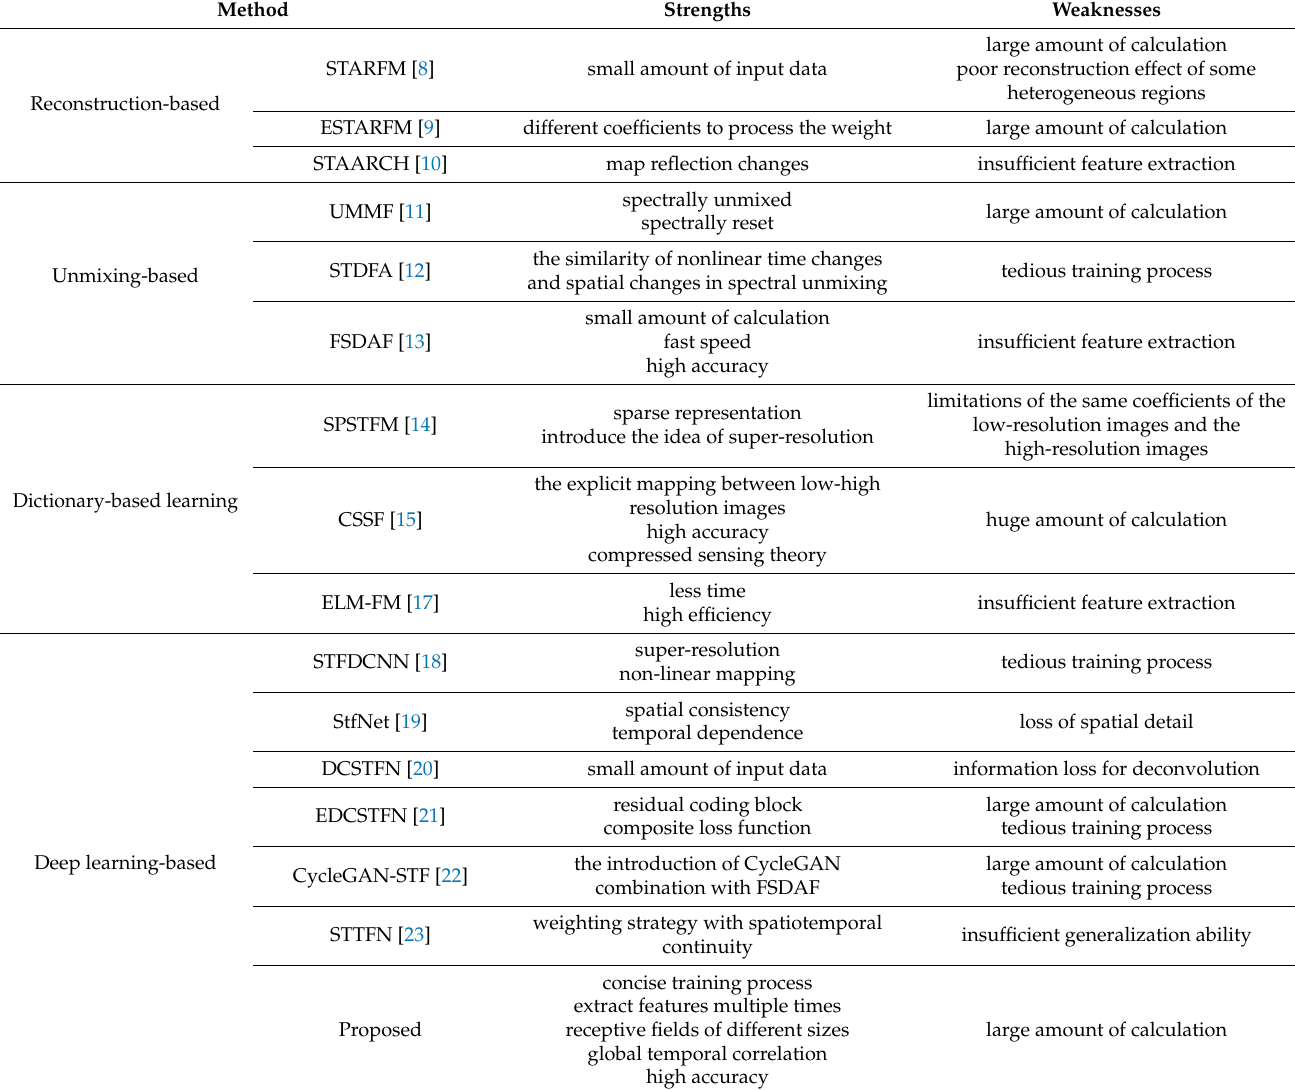
Table 1. Comparison table of strengths and weaknesses of each